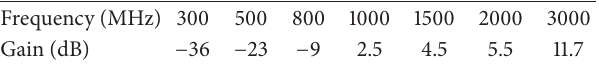
Table 1: Measured gain of the designed antenna.